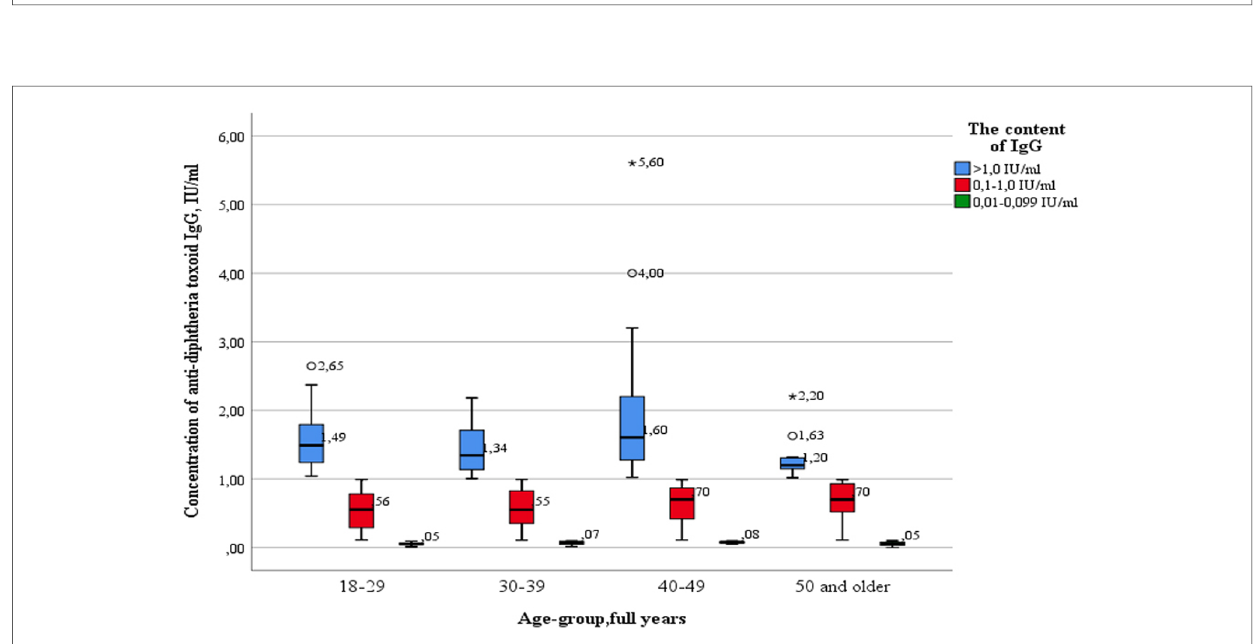
FIGURE 3 The levels of diphtheria immunity in different age groups of healthcare